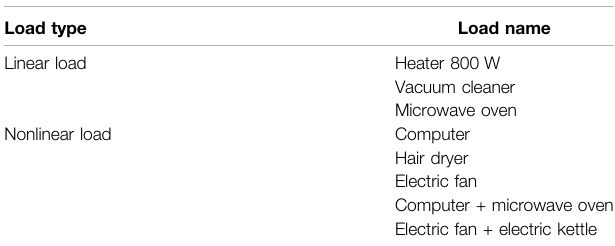
TABLE 5 | Types of loads in the experiment.